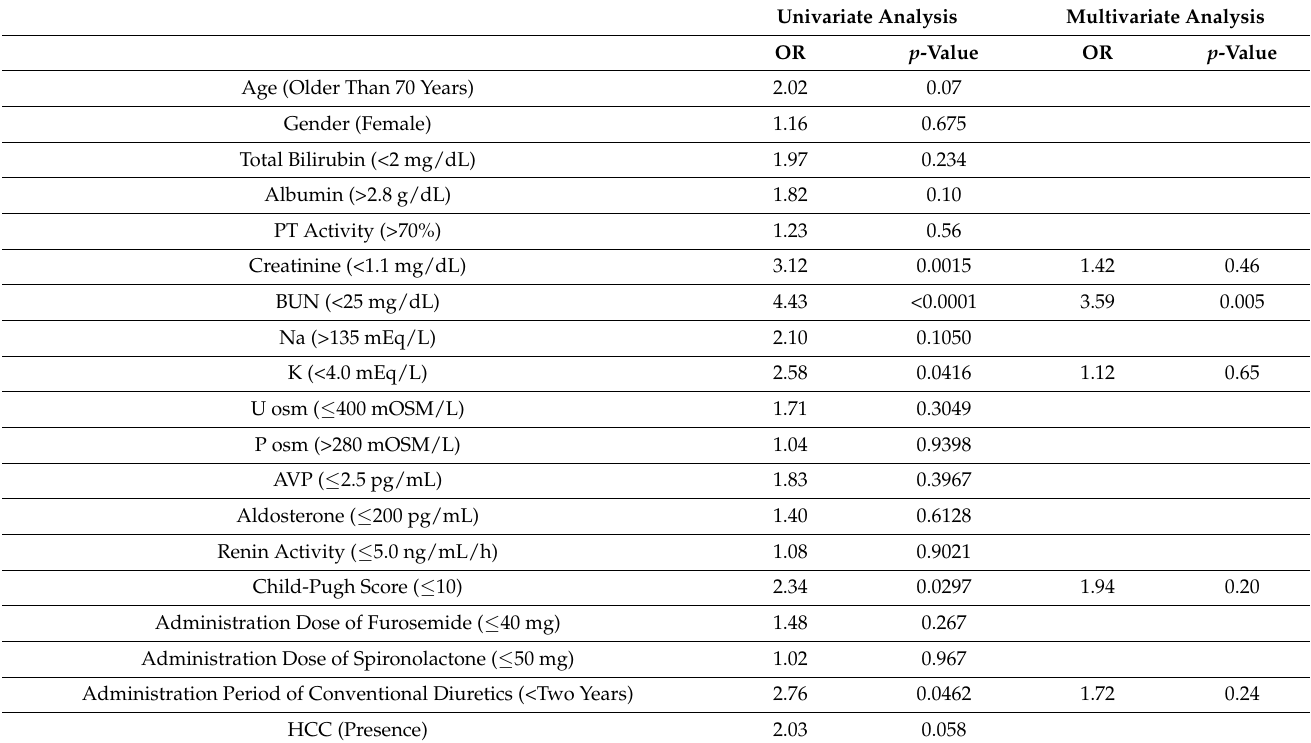
Table 2. Contributing factors to a good response to tolvaptan. A good response to tolvaptan is defined as a 1.5 kg decrease in body weight after one week of